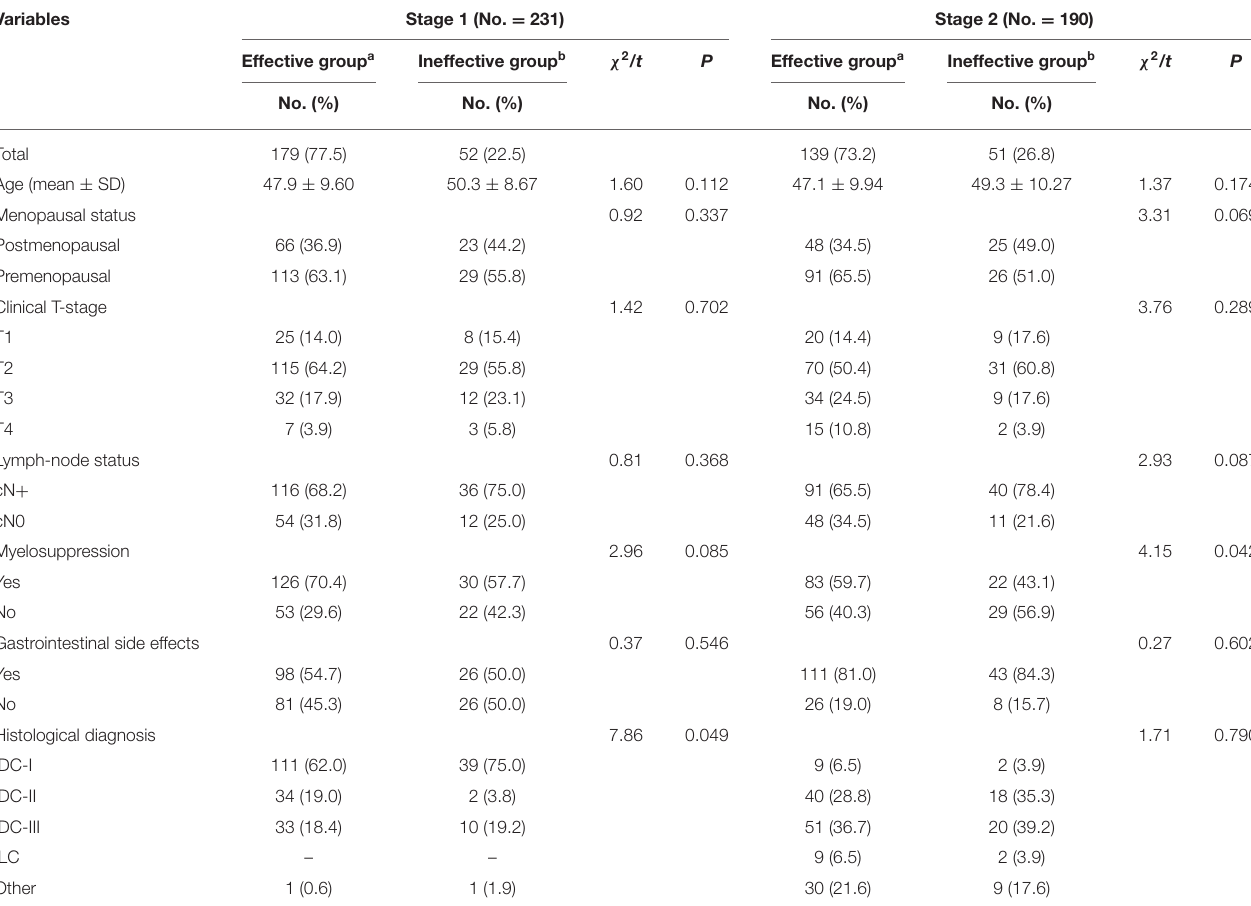
TABLE 1 | Characteristics of participants in the two-stage study. Variables Stage 1 (No. =